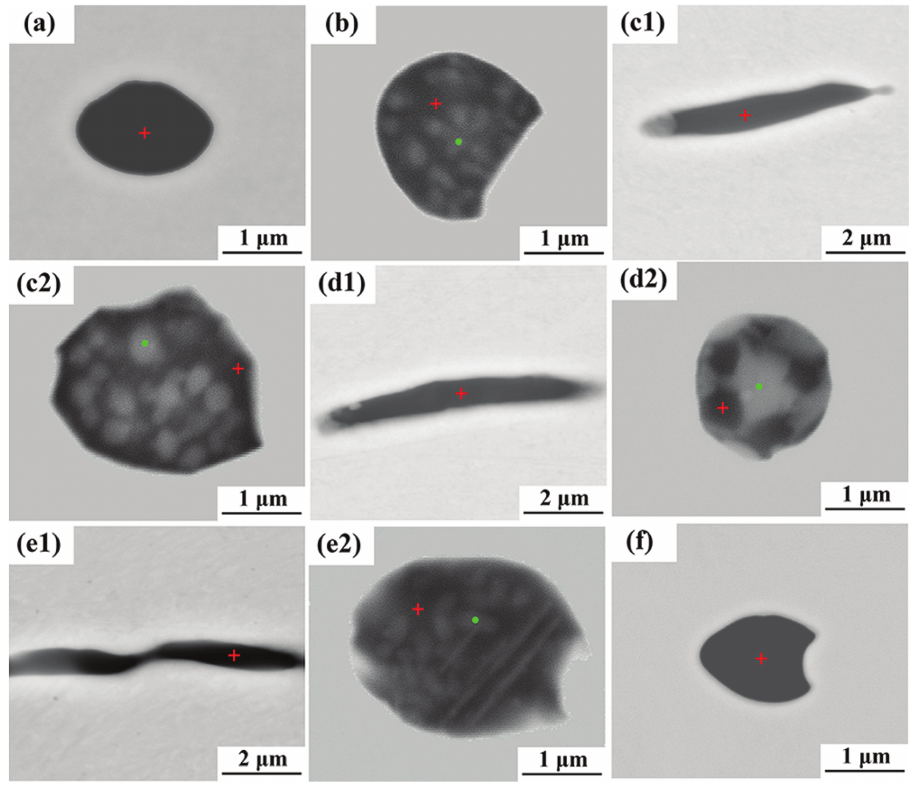
Figure 11: Backscattered electron images of typical inclusions in steel (cross-type dot – black phase, round-type dot – grey phase).